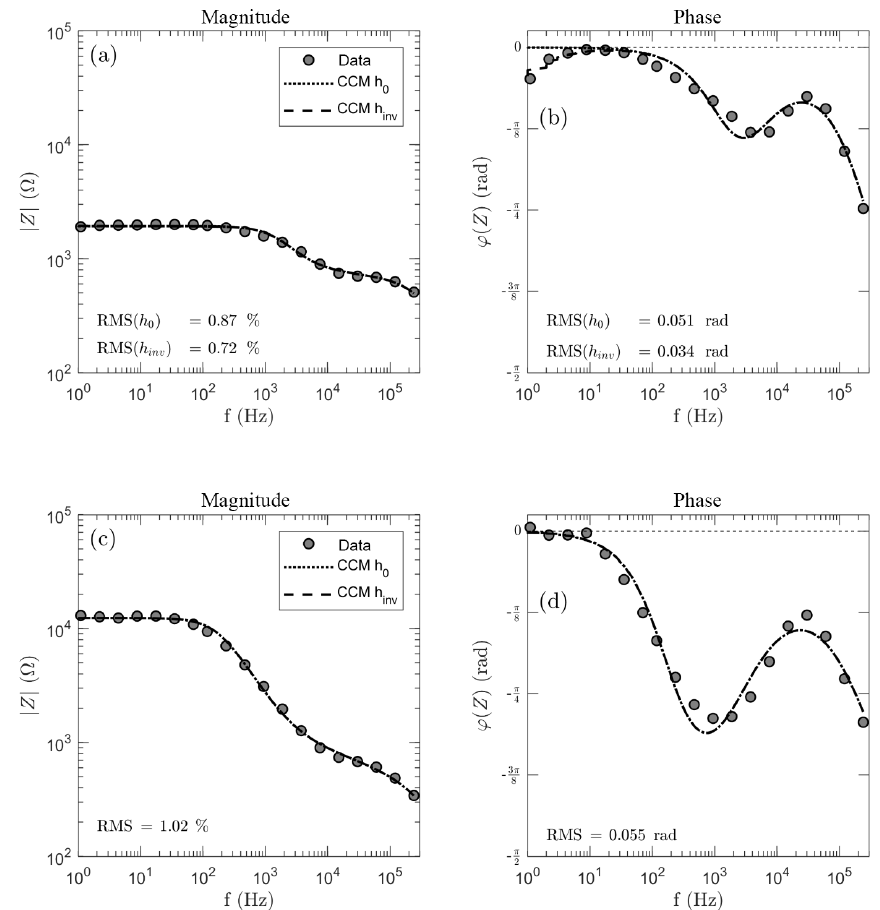
Figure 5. Spectra of two measurements from the Tromsø site. Panels (a) and (b) show data from the lake and (c, d) data from a mea- surement on shore. The figure shows the measured data and the inversion results using the Cole–Cole model. The simulated curves with zero electrode height ( h 0 ) and inverted height ( h inv ) can not be distinguished, except for the phase shift of the lake measurement (b) . Both measurements were taken in a Wenner configuration with a = 1 . 5m. The CCM parameters for the lake measurement are ( h 0 /h inv ) ρ DC = 1 . 82 × 10 4 / 1 . 81 × 10 4 (cid:127) m, ε DC = 374 / 370, ε HF = 8 . 80 / 8 . 83, τ = 4 . 2 × 10 − 5 / 4 . 1 × 10 − 5 s and c = 0 . 93 / 0 . 93. The CCM parame- ters for the onshore measurement are ( h 0 and h inv ) ρ DC = 1 . 2 × 10 5 (cid:127) m, ε DC = 670, ε HF = 12 . 8, τ = 7 . 1 × 10 − 5 s and c = 0 .